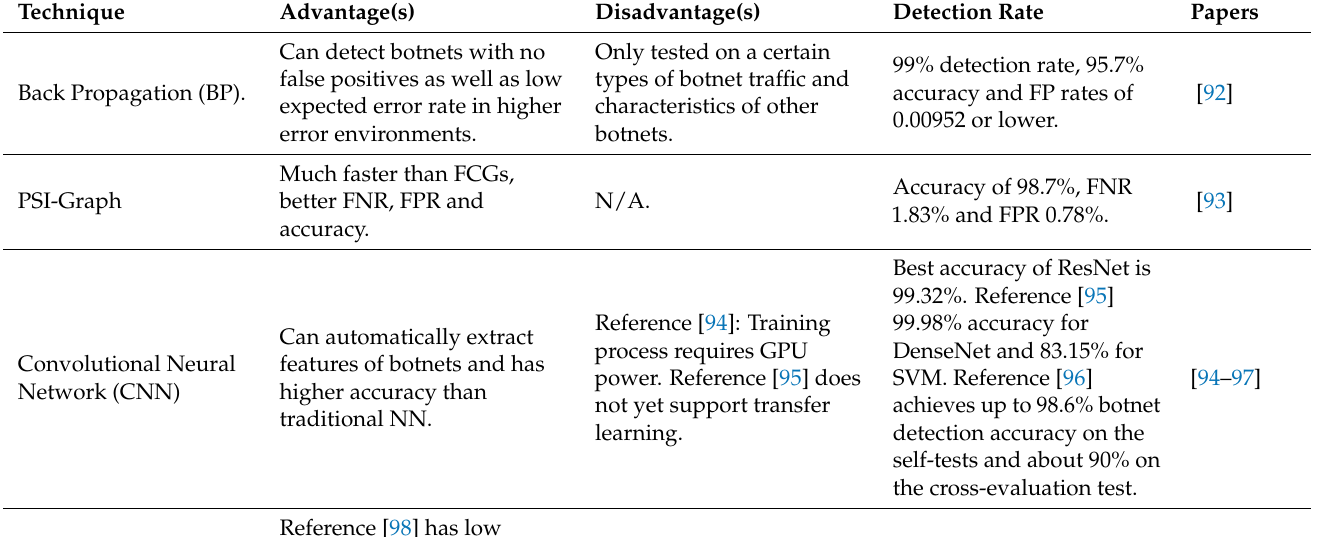
Back Propagation